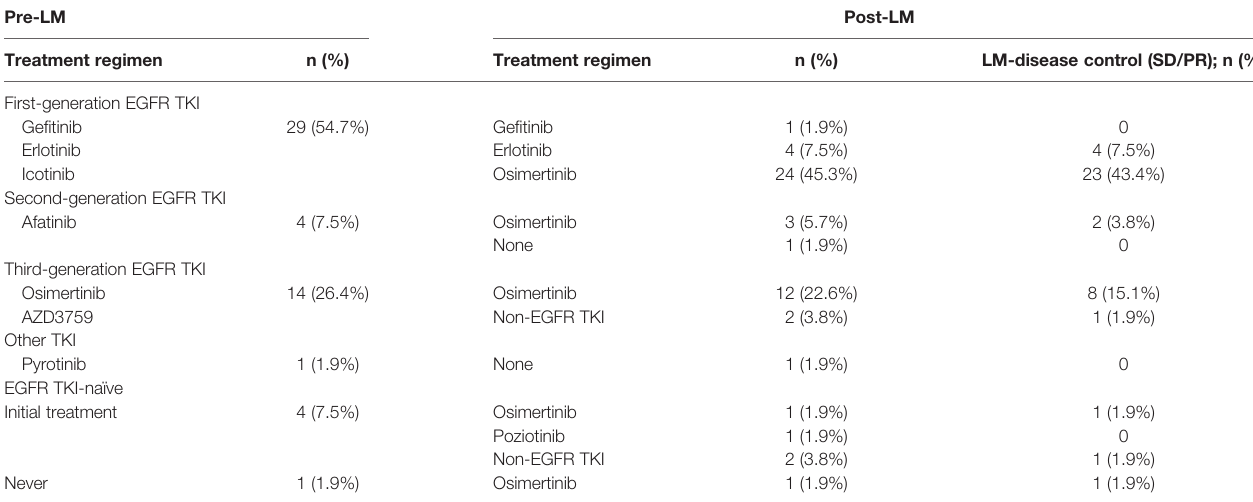
TABLE 2 | Distribution of our cohort (n = 53) based on treatment regimens received before and following diagnosis of leptomeningeal metastasis (LM). Pre-LM